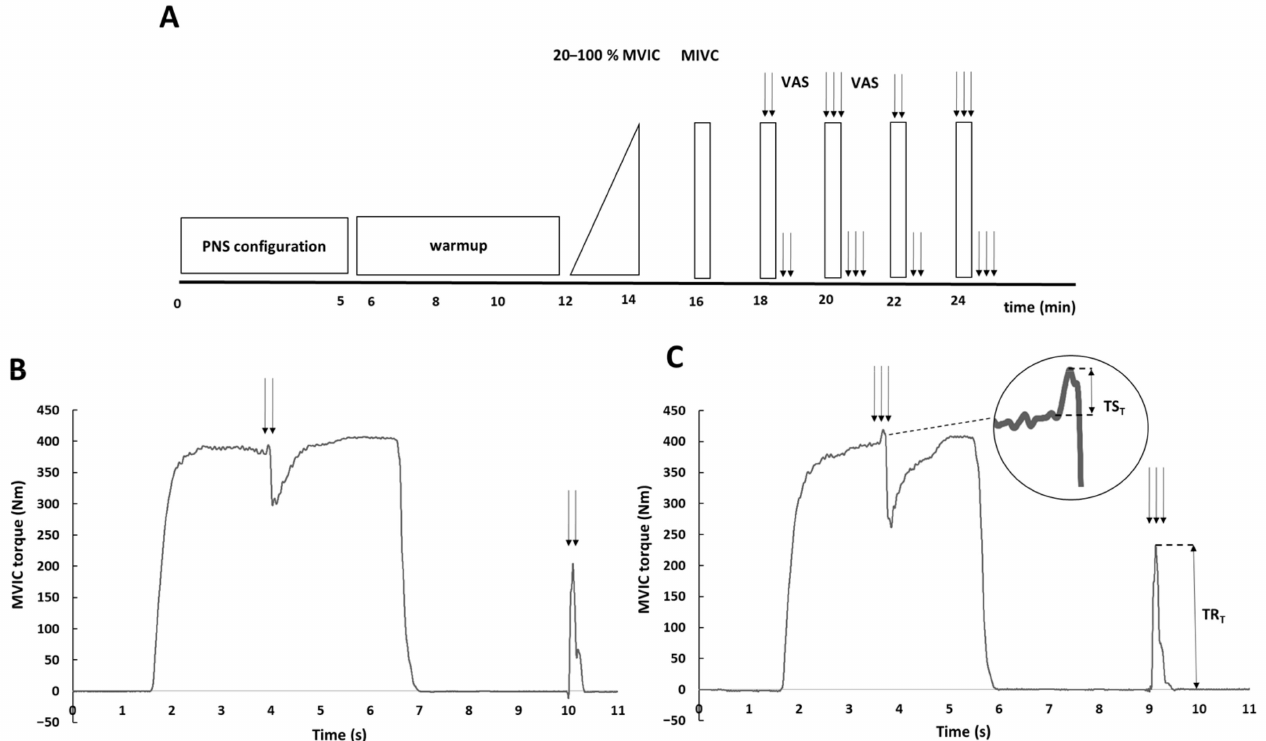
Figure 1. Overview of the neuromuscular testing protocol (( A )—timeline of the experiment; ( B , C )—typical examples of raw torque curves over time for one participant). Supramaximal paired ( B ) and triple ( C ) stimuli were interpolated during and immediately after MVIC (maximal voluntary isometric contraction). PNS—peripheral nerve stimulation; ↓↓ —paired electrical stimuli; ↓↓↓ —triple electrical stimuli; VAS—visual analogue scale; TS T —superimposed triplet-evoked torque; TR T —resting triplet- evoked